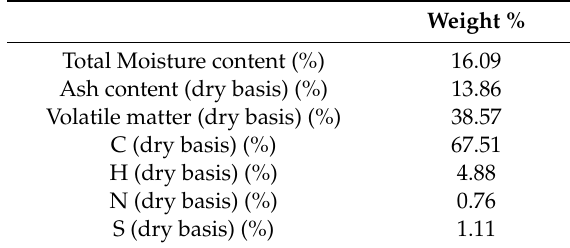
Table 2. Proximate and ultimate analysis of lignite.